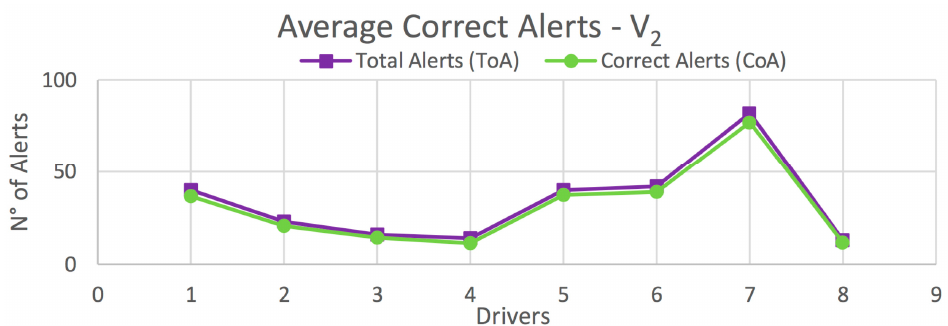
Figure 13. Average total correct alerts on all routes for V 2 ( Heavy Vehicle ). Table 4. Percentage of correct alerts for V 2 (Heavy Vehicle): Route 1, Route 2, Route 3 and all routes. Percentage of Correct Alerts [%]